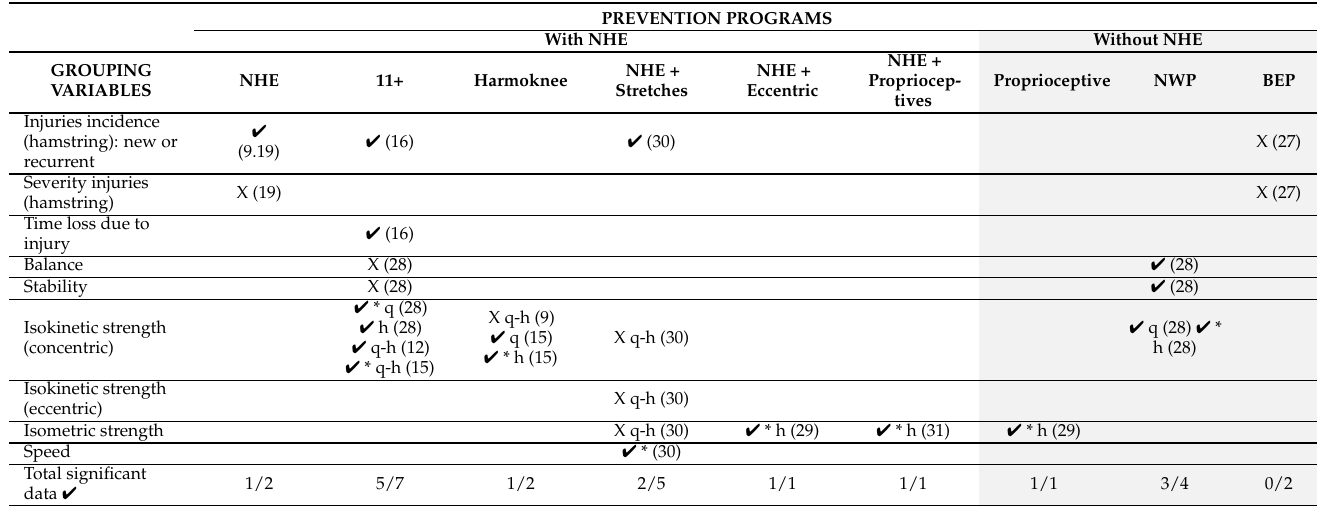
Table 3. Significance and effectiveness of prevention protocols regarding different grouping variables. PREVENTION PROGRAMS With